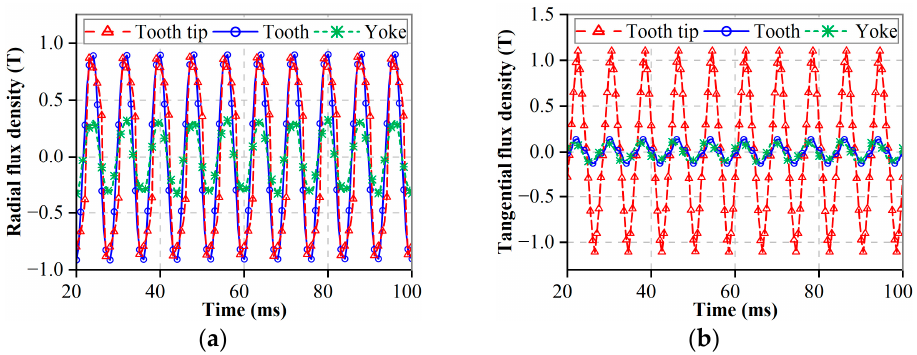
Figure 5. Magnetic flux density time-varying waveform of the stator core: ( a ) Radial component; ( b ) Tangential component.